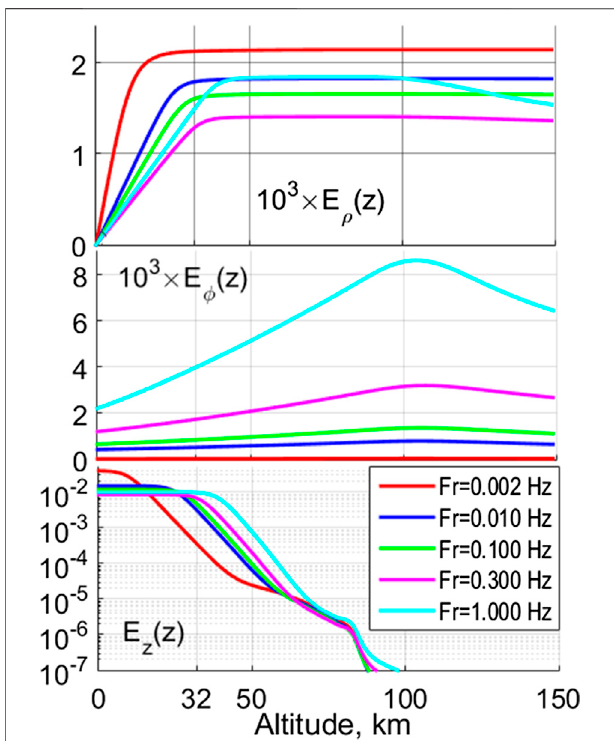
FIGURE 7 | The altitudinal pro fi les of the horizontal electric components E ρ ( z ), E ϕ ( z ) at ρ (cid:2) ρ max and the vertical component E z ( z ) at ρ (cid:2) 0.